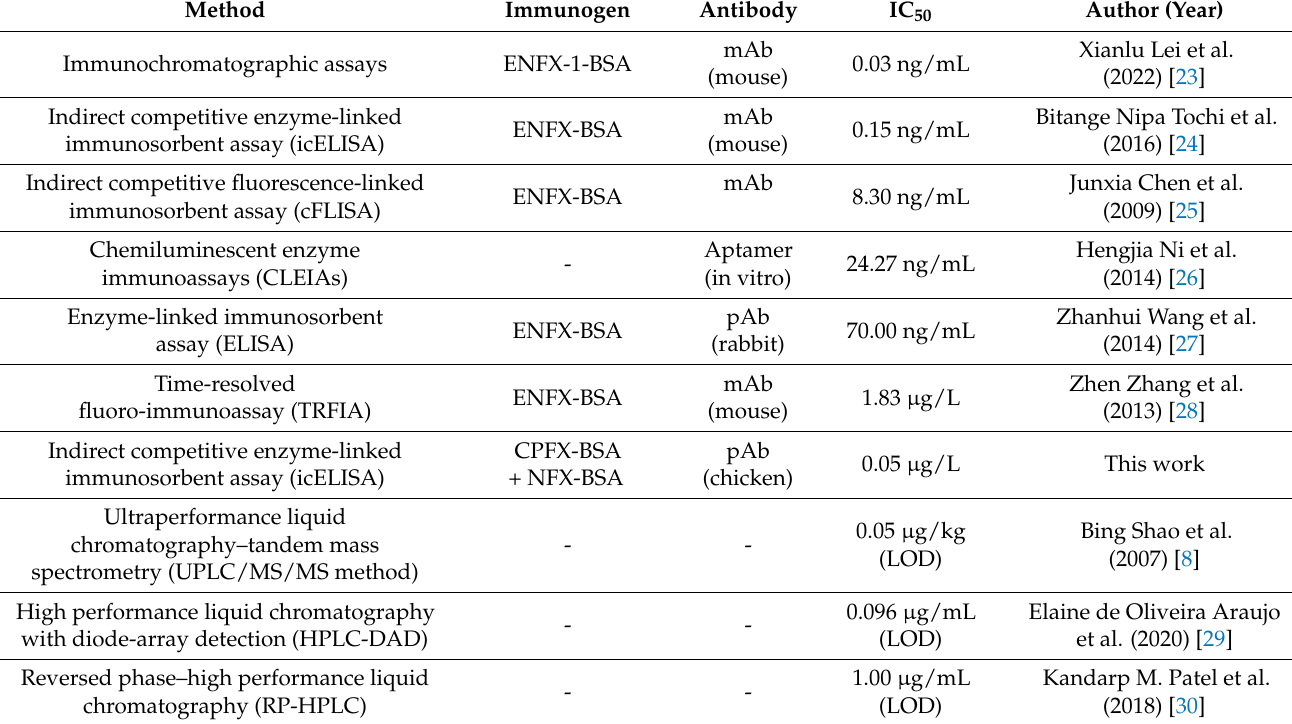
Table 4. Comparison of various ELISA approaches for enrofloxacin